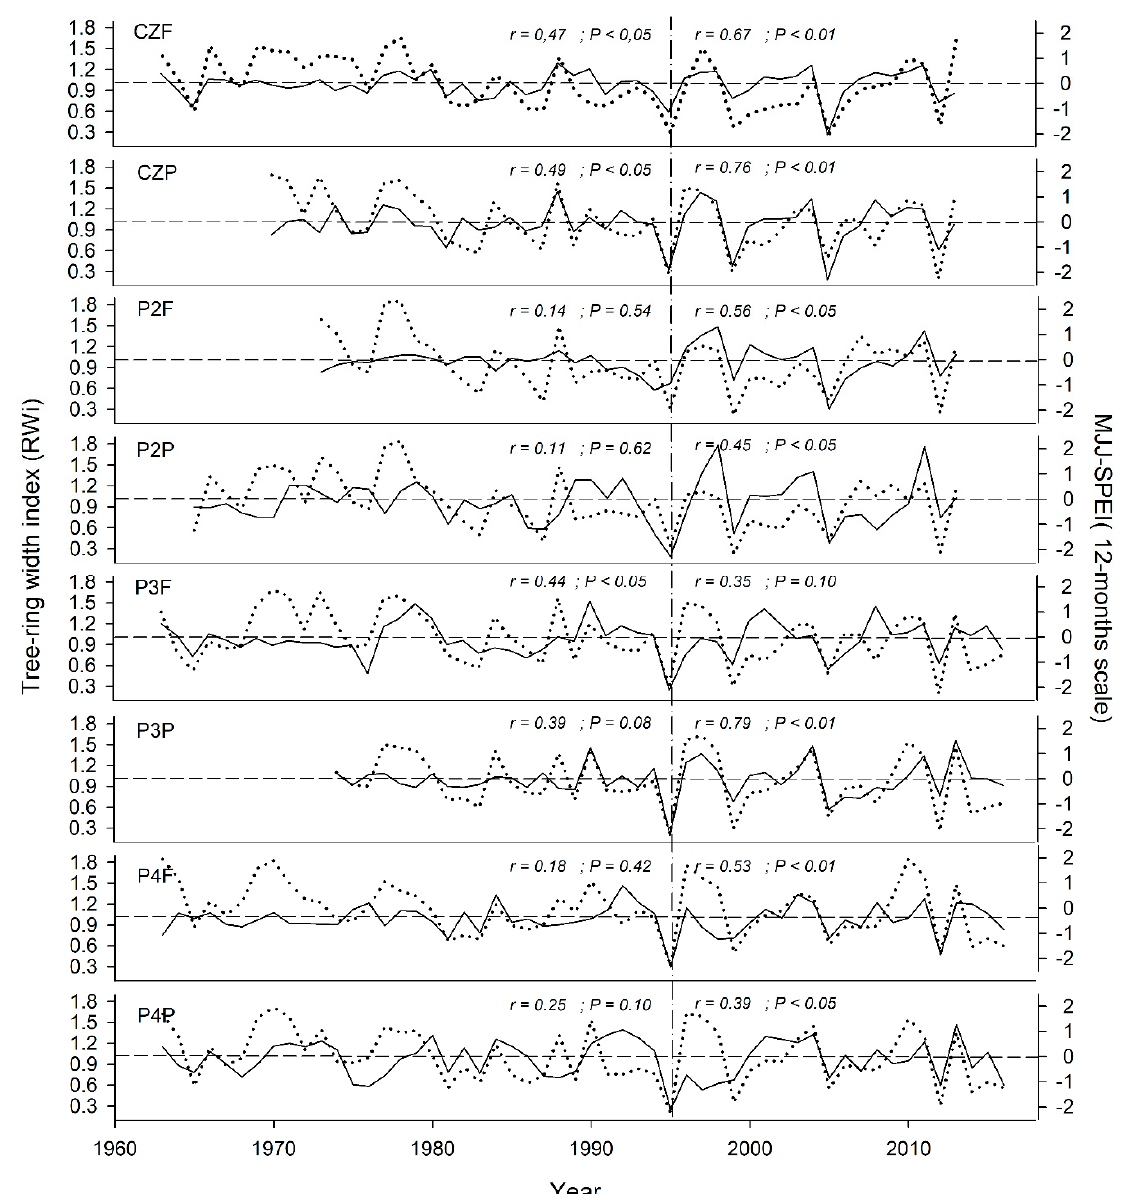
Figure 5. Site chronologies (tree-ring width indices, RWI; solid lines) for the studied stands and the May to July standard precipitation-evapotranspiration index (MJJ-SPEI) calculated at the 12-month scale (dotted lines) for the period 1960–2016. The Pearson correlations (r) between the RWI and SPEI12 for May, June, July (MJJ-SPEI), and the associated probability values ( p ) are shown for each site, for the pre-drought (1995) period (1975–1995; left) and the post-drought period (1995–2015; right).